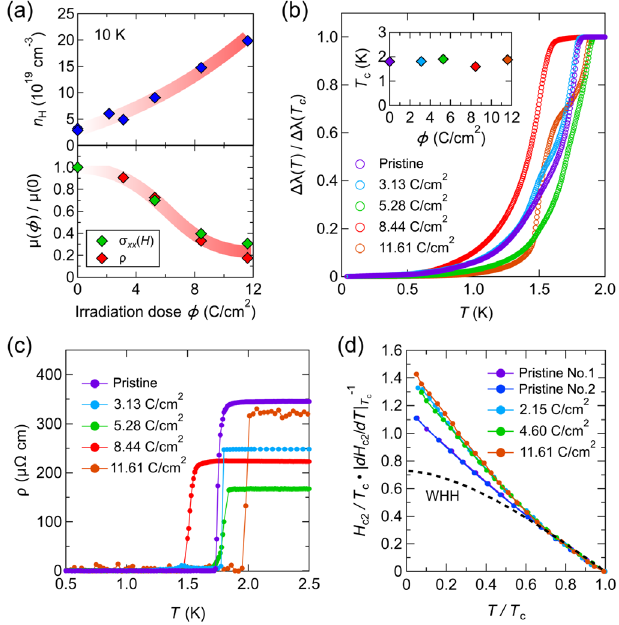
FIG. 2. Physical properties of pristine and electron-irradiated LuPdBi. (a) Upper and lower panels depict the carrier density n H (blue diamonds) and normalized mobility μ ð ϕ Þ = μ ð 0 Þ (green and red diamonds) extracted from magnetotransport measurements at T ¼ 10 K as a function of the irradiation dose ϕ , respectively. The green and red diamonds represent the μ ð ϕ Þ = μ ð 0 Þ values calculated from the magnetoconductance σ xx ð H Þ and resistivity ρ , respectively (see Appendix D). (b) Normalized change of penetration depth as a function of temperature Δ λ ð T Þ in the pristine (purple), 3.13 (light-blue), 5.28 (green), 8.44 (red), and 11 . 61 C = cm 2 (brown) irradiated samples. The inset shows T c [defined at the onset of Δ λ ð T Þ ] as a function of the irradiation dose. (c) Temperature dependence of resistivity at low temper- atures in the pristine and irradiated samples. (d) Reduced upper critical field as a function of T=T in the pristine (purple and c blue), 2.15 (light-blue), 4.80 (green), and 11 . 61 C = cm 2 (brown) irradiated samples. The black dashed line represents the standard temperature dependence of H in the WHH c 2